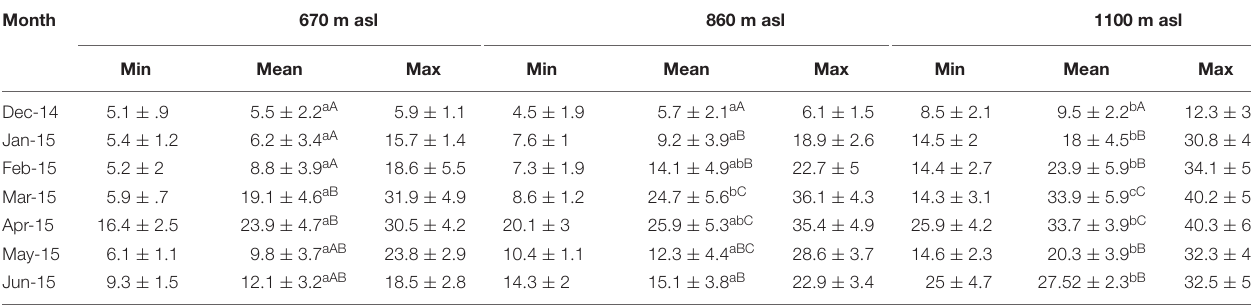
TABLE 2 | Soil water content (SWC, %) in the study period at three altitudes.